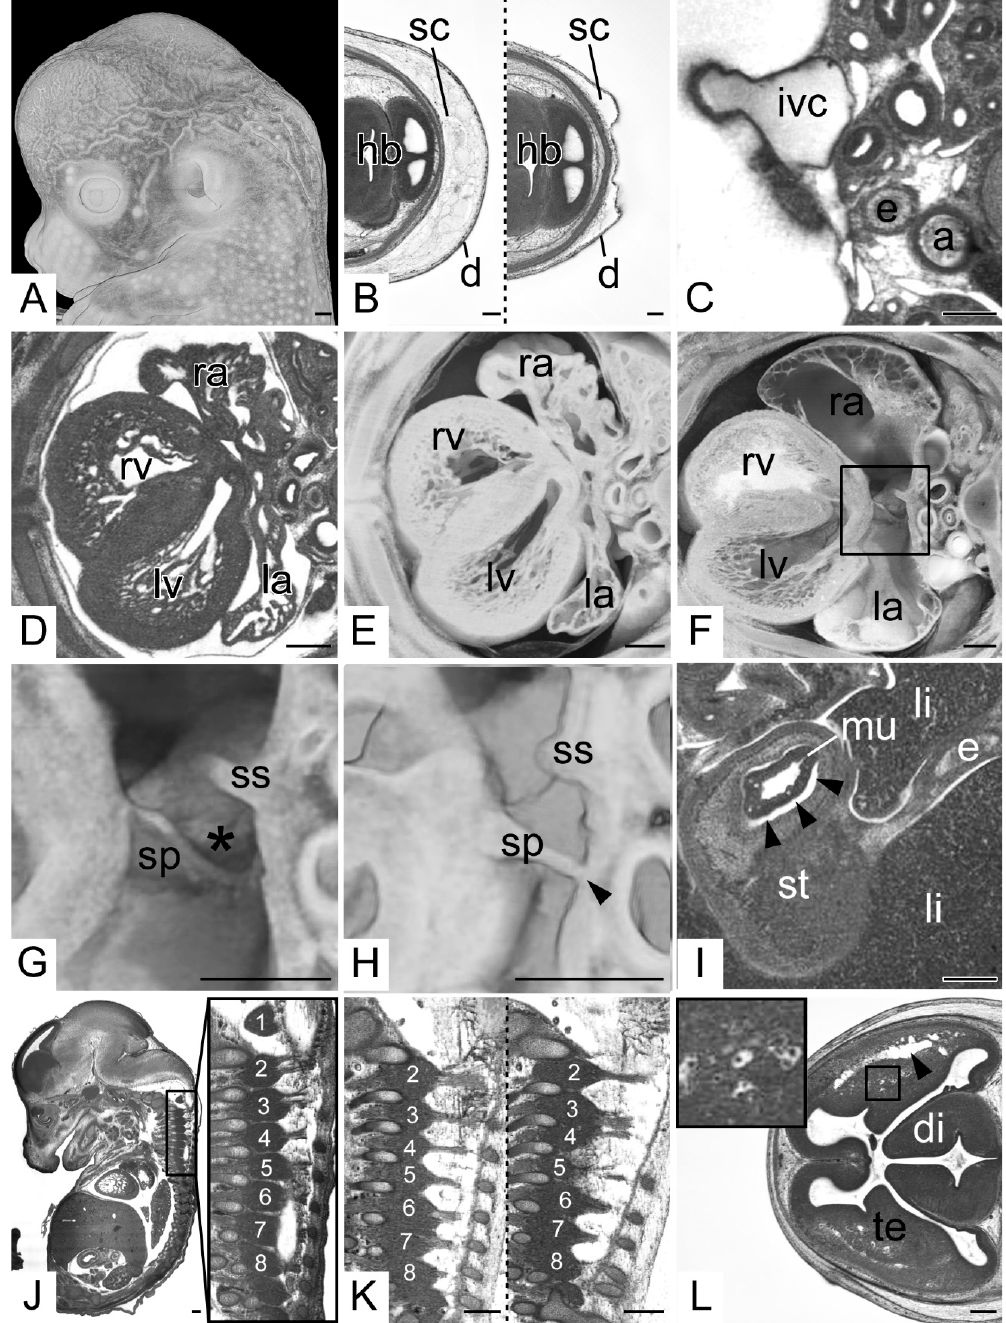
Figure 4. Shrinkage artefacts. ( A ) Wrinkled skin. Volume model from left. ( B ) Thickness of the subcutis (sc). Transverse HREM sections, ventral to the left. ( C ) Cross section of the inferior vena cava (ivc). Compare shape to aorta (a). Transverse HREM section, ventral to the left. ( D – F ) Atrial appendages. ( D ) Transverse HREM section, ventral to the left. ( E ) Transected 3D model. ( F ) Control. Note the wall shrinkages and cavity dimensions (ra, la). ( G , H ) Foramen ovale (asterisk). Transected semitransparent volume models. ( G ) is a magnification of ( F ) and serves as control. ( H ) Septum primum (sp) touching the dorsal atrial wall (arrow head). The foramen ovale appears as if closed. ( I ) Artificial detachment of stomach (st) mucosa (mu). Transverse HREM section ( J , K ) Cervical spinal ganglia (1–8). Sagittal resections, ventral to the left. ( J ) Demarcated ganglion material. ( K ) Connected ganglia (2–8) in a wildtype (left side) and a 4933434E20Rik mutant (right side). Note the separated dorsal roots in the wildtype and the mingled dorsal roots of 3 and 4 in the mutant. ( L ) Spongy appearance of brain tissue. Elongated cavities profound to the superolateral cerebral cortex (arrow head) and cavities surrounding intracerebral